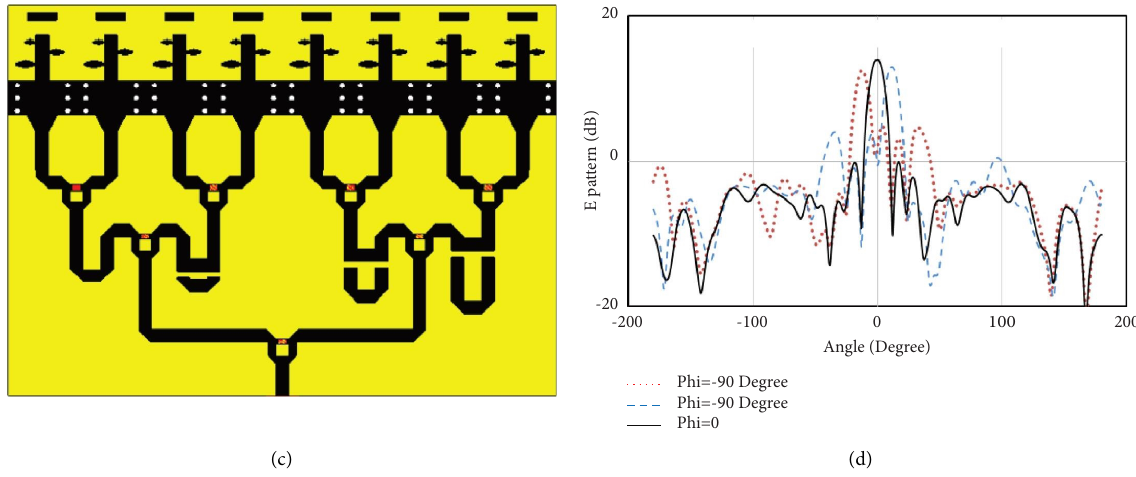
Figure 12: (a). Te linear array antenna with beam rotation ability, (b). Green diodes “on”, and Blue diodes “of,” (c). Green diodes “of,” and Blue diodes “on,” (d). the result of beam rotation for φ � 90 ( θ � 11 ° ) and φ � − 90 ( θ � − 11 ° ) degrees with respect to 0 degree. Table 4: Comparison of some beam steering. Ref.